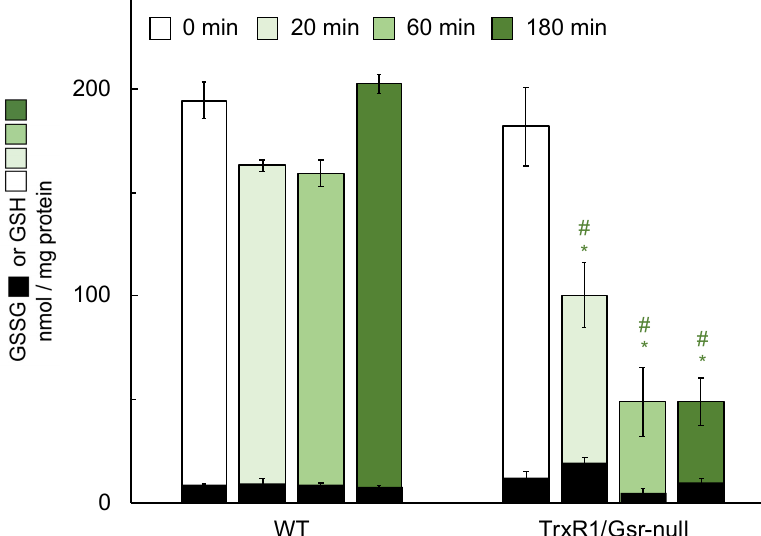
Figure 5. Hepatic levels of GSH and GSSG following short-term DHA treatment. Mice received a single dose of 0.3 mg/g DHA and were harvested at the indicated times thereafter (0 min mice received no DHA). n > 5 animals for each condition. Green denotes GSH; black denotes corresponding GSSG in the same sample. Bars, mean ± s.e.m.; *, p < 0.05 versus un- treated control of same genotype; #, p < 0.05 versus WT under same treatment using one-way ANOVA and Tukey–Kramer post hoc, pair-wise comparison.